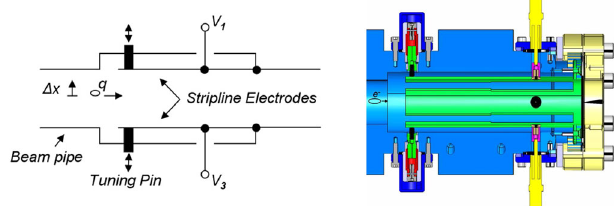
FIG. 29. Resonant stripline BPM pickup schematics (left) and mechanical drawing (right) [80].